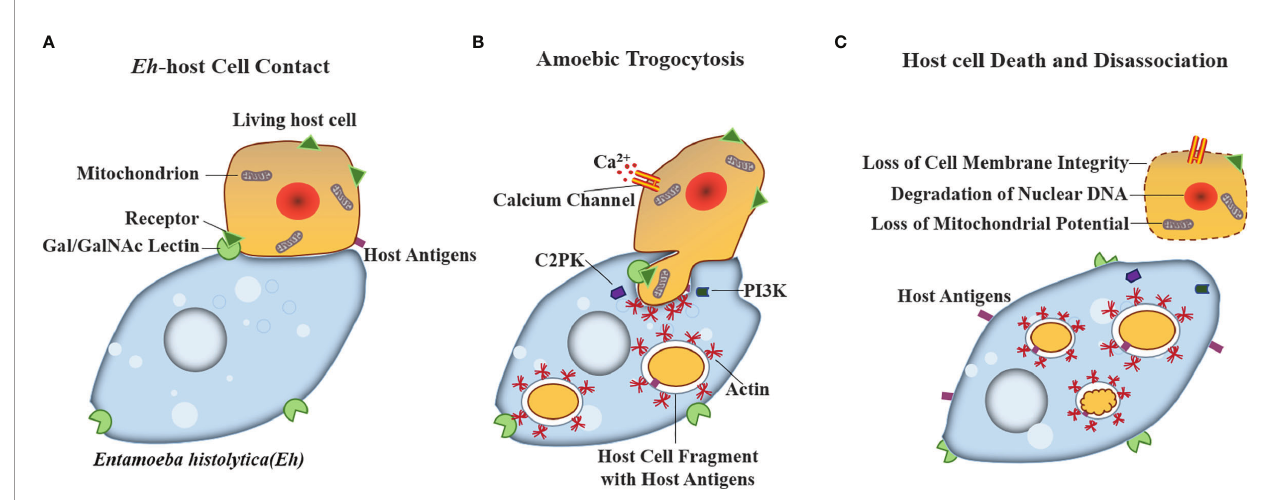
FIGURE 2 | Model for host cell killing via amoebic trogocytosis. Entamoeba histolytica use trogocytosis to achieve kill host cells by three steps: (A) Contact to host glycoproteins containing Gal/GalNAc is mediated by the amoeba surface Gal/GalNAc lectin. (B) Amoebic trogocytosis is initiated. The process involves the signal transduction including PI3K and EhC2PK, both of which induce actin polymerization to ingest fragments of host cell material. Host cell intracellular calcium becomes elevated because of the activation of calcium channels. (C) Host cell death can be re fl ected in degradation of nuclear DNA and the loss of membrane integrity and mitochondrial